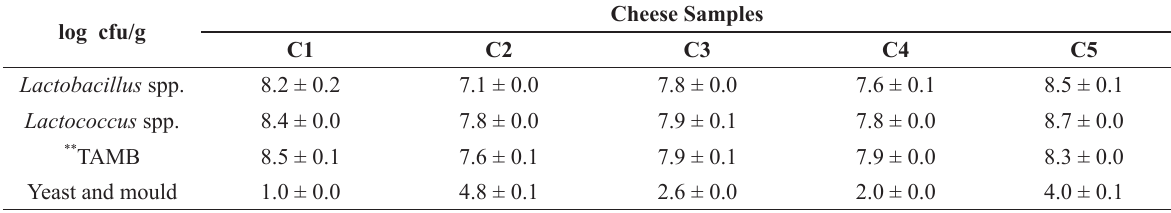
Microbiological properties of Söğle cheese samples after ripening period of three months (n = 2) *